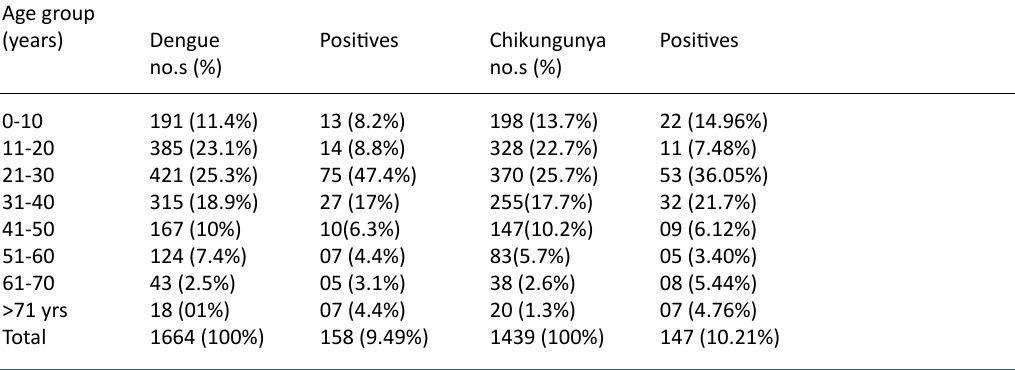
Table 3. Age-wise distribution of Dengue and Chikungunya infection 2017 Age